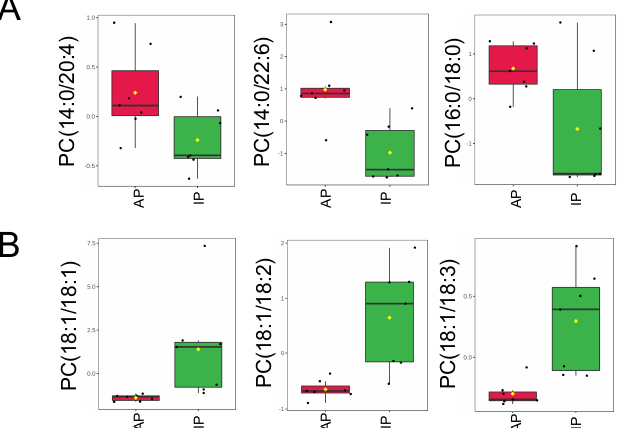
Figure 6. Phosphatidylcholine levels in uEVs isolated from urine collected during the inactive and active phases of spontaneously hypertensive aged male mice. ( A ) Normalized plots showing 3 PC’s that are significantly increased in EVs isolated from urine samples collected in the active phase (AP) compared to the inactive phase (IP). ( B ) Normalized plots showing 3 PC’s that are significantly decreased in EVs from the AP group compared to the IP group. Data were normalized to the median with Pareto scaling and the plots were made in MetaboAnalyst software. n = 7 samples per group. EVs isolated from AP urine are in red and EVs isolated from IP urine are in green. The concentration of each lipid on the y-axis is given in µ